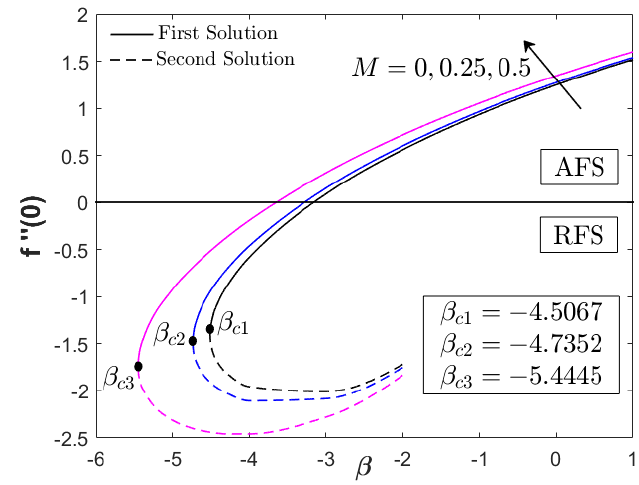
( ) 0 f ′′ for various M (magnetic parameter). Figure 2. ( ) Figure 2. f (cid:48)(cid:48) ( 0 ) for various M (magnetic parameter). 0 f ′′ for various M (magnetic parameter). Figure 2.